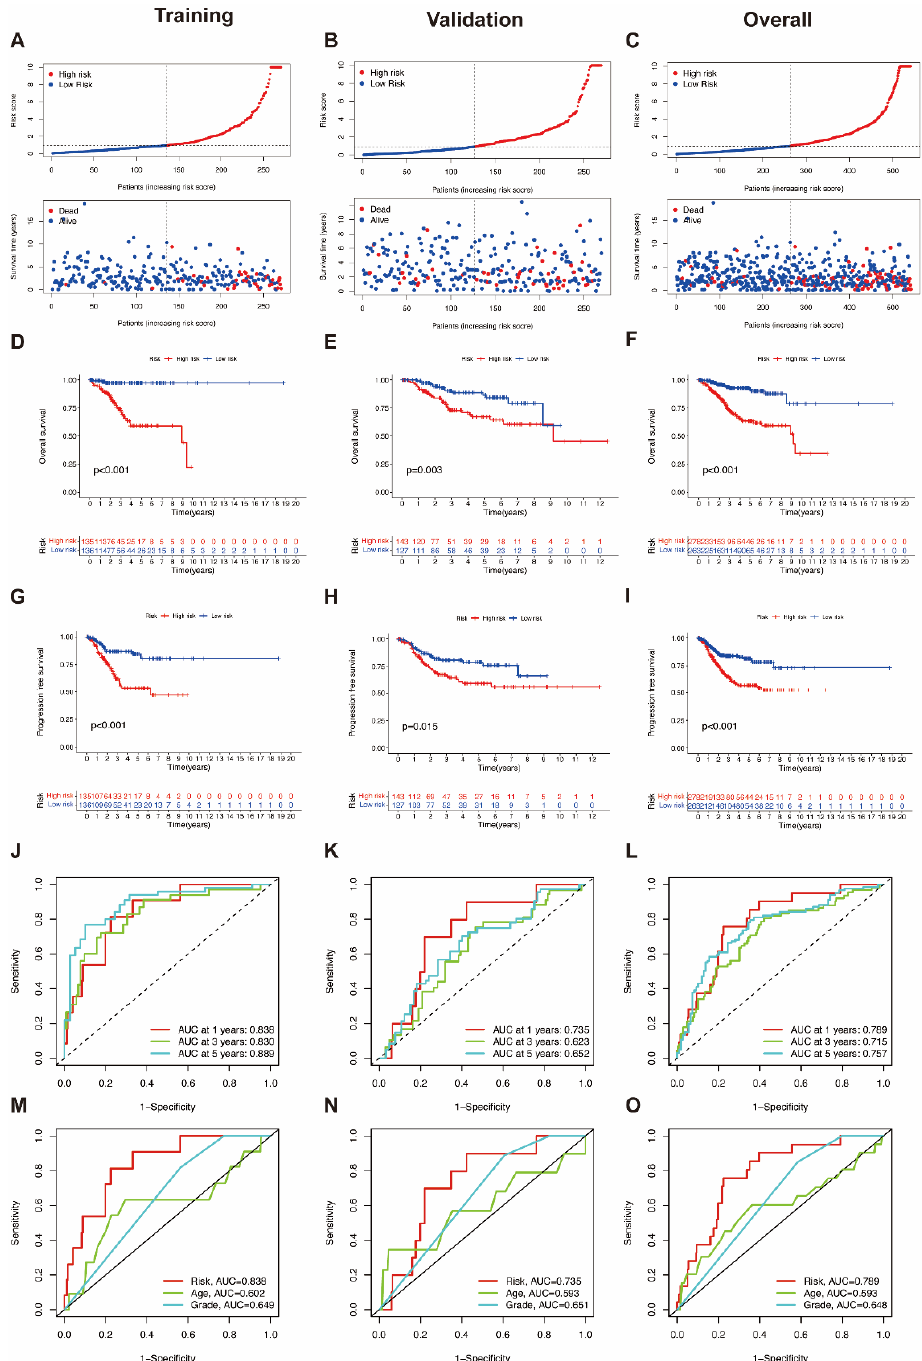
Figure 3. Construction and validation of the prognostic model based on MRLs. ( A – C ) The distribution of risk scores and overall survival status in the training group, validation group and overall group. ( D – F ) The Kaplan–Meier curves of overall survival rates in the training group, validation group and overall group. ( G – I ) The Kaplan–Meier curves of progression-free survival rates in the training group, validation group and overall group. ( J – L ) Time-dependent ROC curves for the training group, validation group, and overall group. ( M – O ) Clinicopathological characteristics ROC curves for the training group, validation group, and overall group.